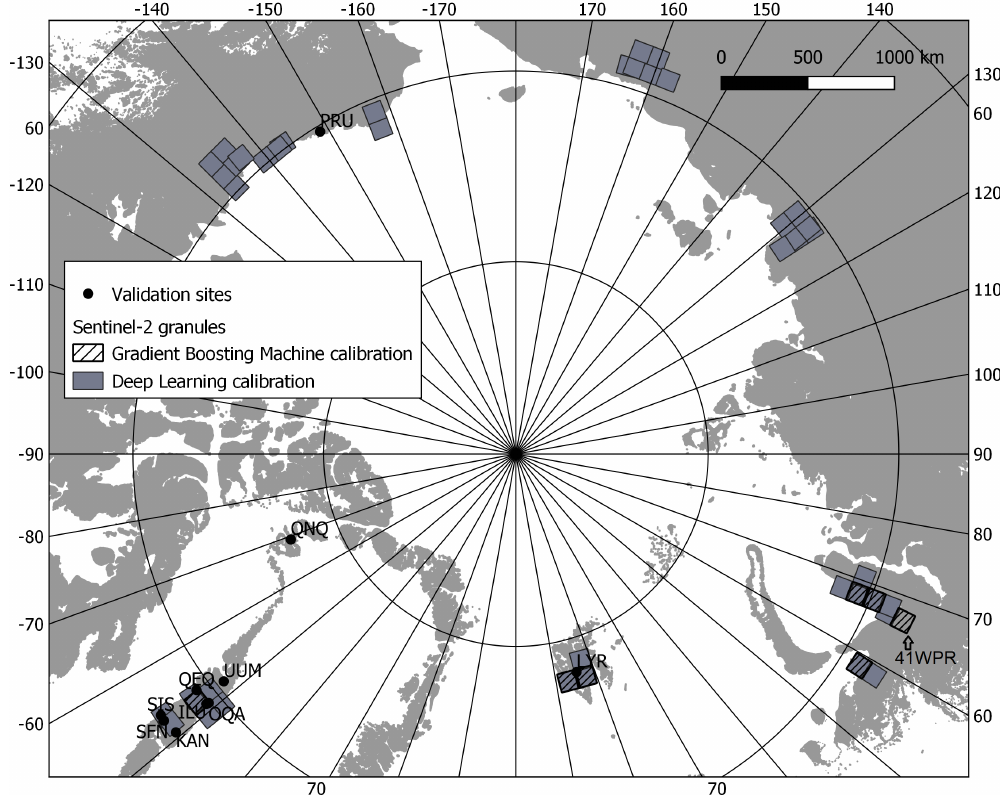
Figure 3. Overview of calibration granules (based on Sentinel-2 tiling) and external validation sites (ILU—Ilulissat, KAN—Kangerlussuaq, LYR—Longyearbyen, OQA—Oqaatsut, PRU—Prudhoe Bay, QEQ—Qeqertarsuaq, QNQ—Qaanaaq, SFN—Sarfannguit, SIS—Sisimiut, UUM—Uummannaq). Dark gray—sporadic to continuous permafrost (source: [56]). Granule 41WPR is pointed out as it is used for Gradient Boosting Machine calibration